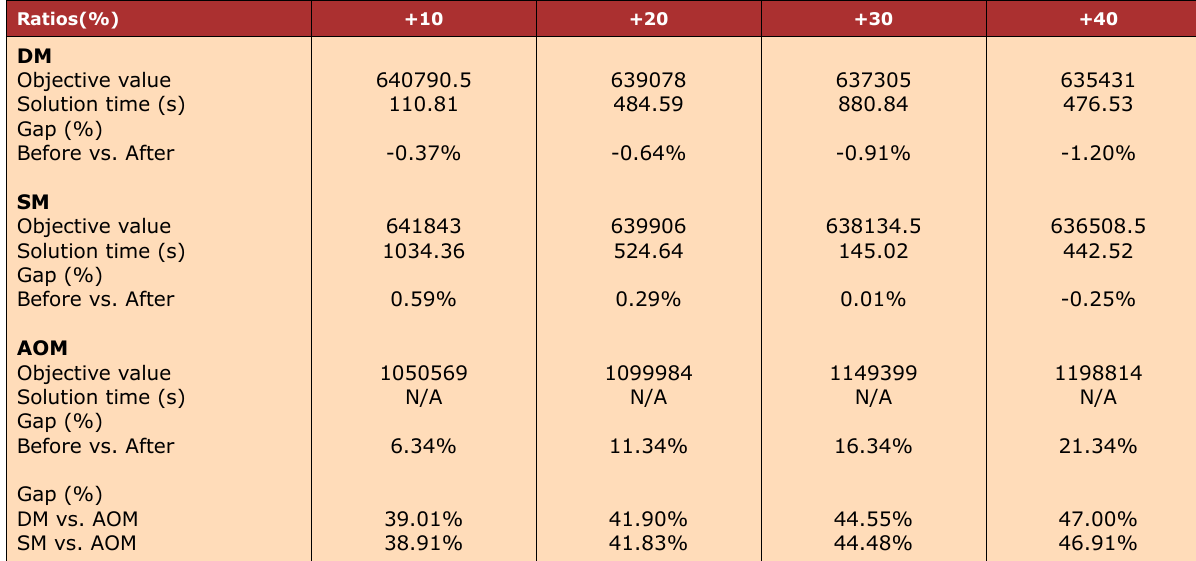
Table 4. Sensitivity analysis of the change ratio of